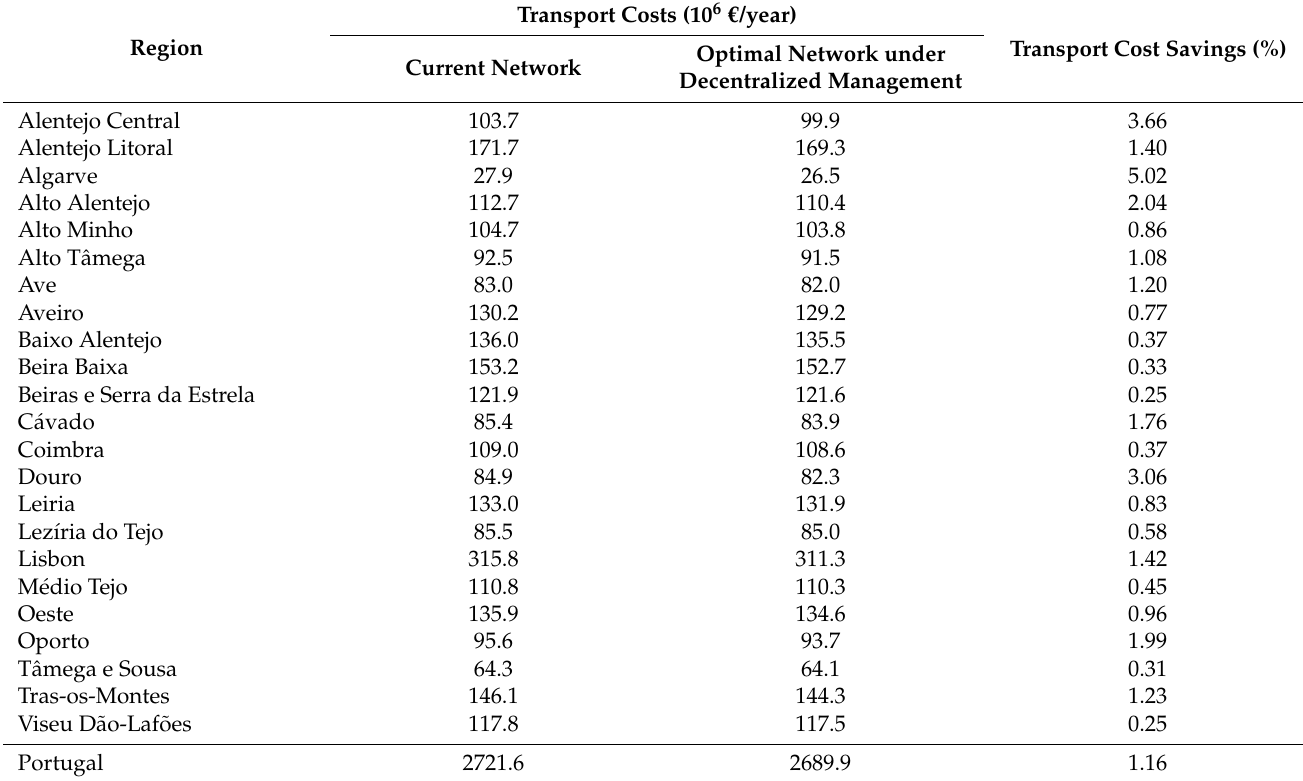
Table 5. Freight transport costs of NUTS 3 before and after the implementation of the optimal intermodal terminal network under decentralized